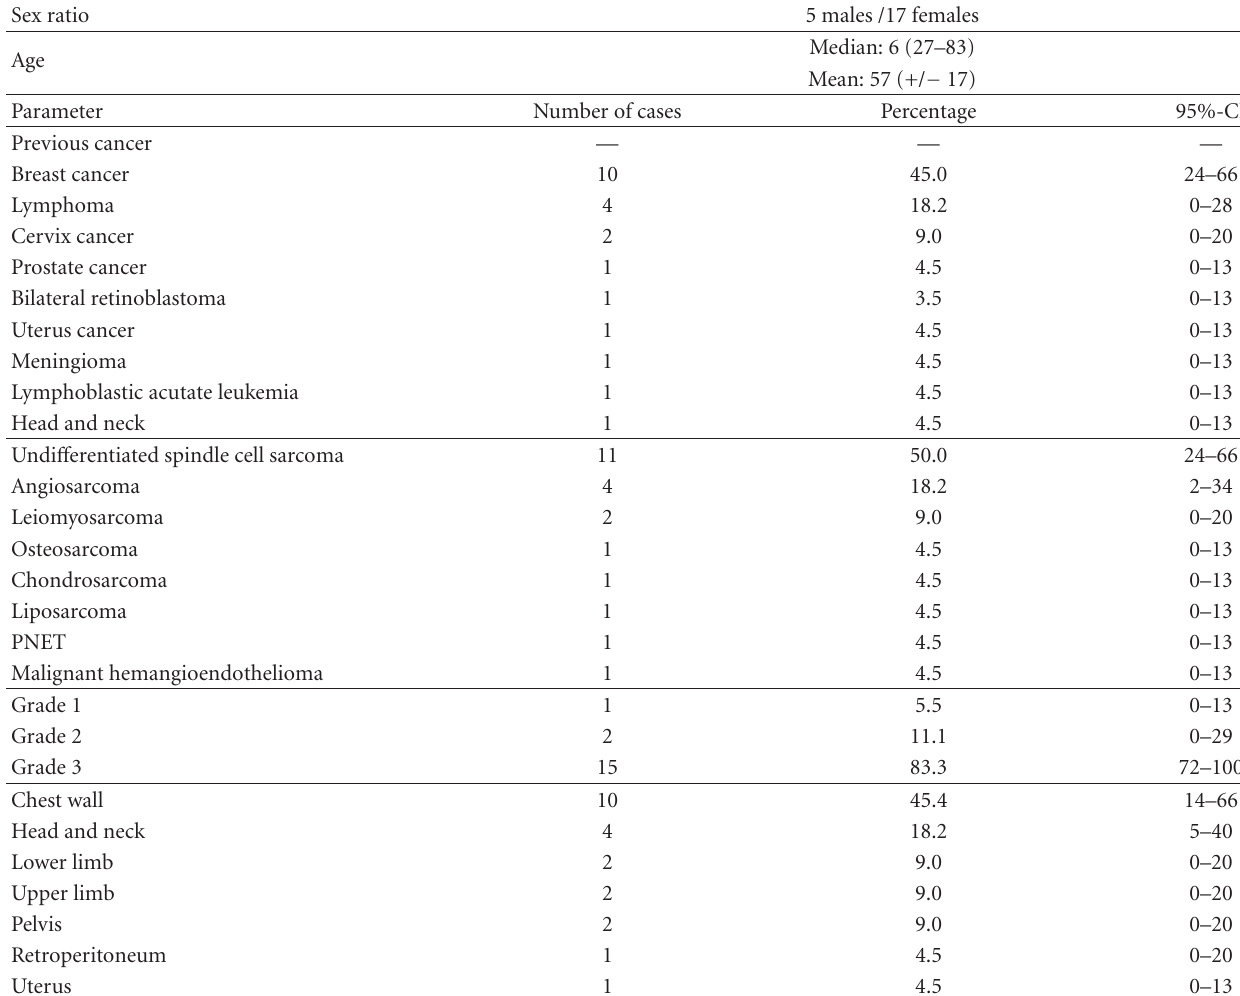
Table 3: Radiation-induced